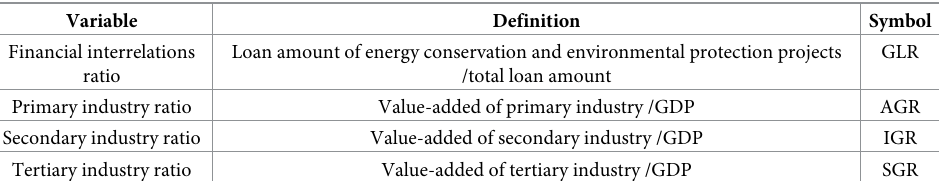
Table 1. Definition of